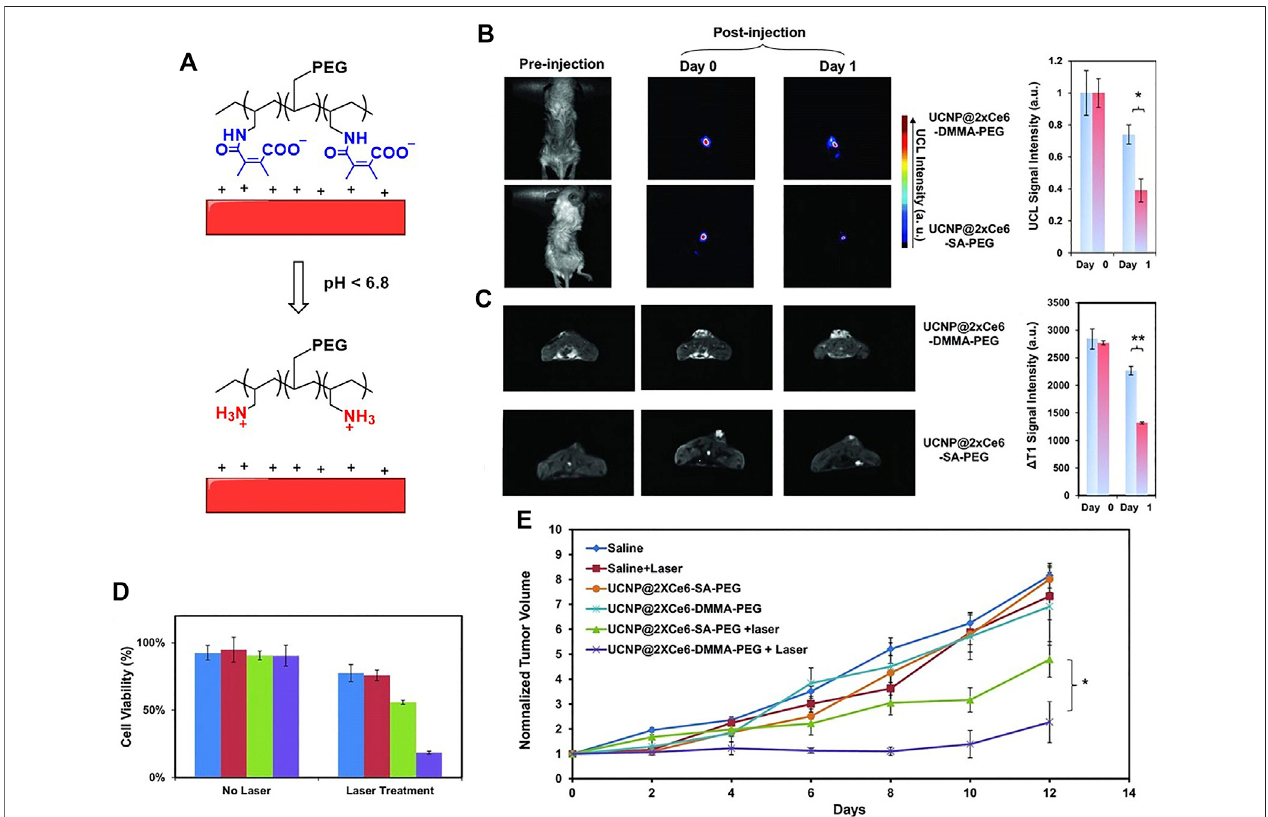
FIGURE 6 | (A) Schematic illustration of pH-responsive smart theranostic UCNPs, showing the detachment of PAH-DMMA-PEG from the positively charged nanoparticlesurfaceunderpH6.8; (B) invivo UCLimagesand (C) T 1 MRimagesofmiceafterintratumoralinjectionwithUCNP@2xCe6-DMMA-PEGorUCNP@2xCe6-SA- PEG.Theimagesweretakenatdifferenttimespost-injection; (D) cellviabilitydataofHeLacellsaftervarioustreatmentsindicatedwithandwithoutthe980 nmlaserirradiation asevaluatedbythestandardMTTassay; (E)